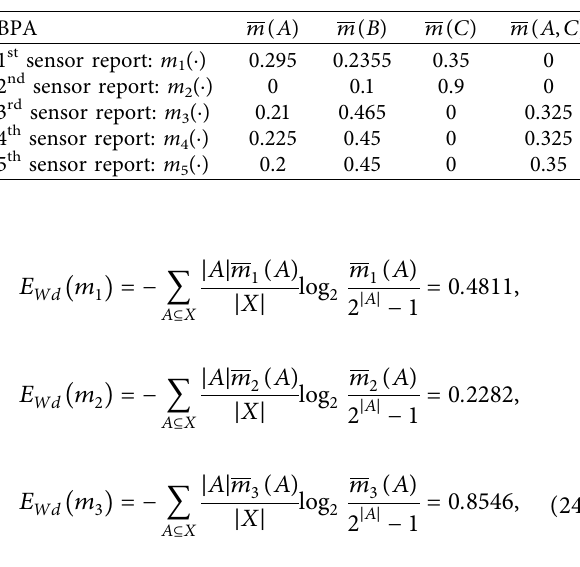
Table 2: The negation of